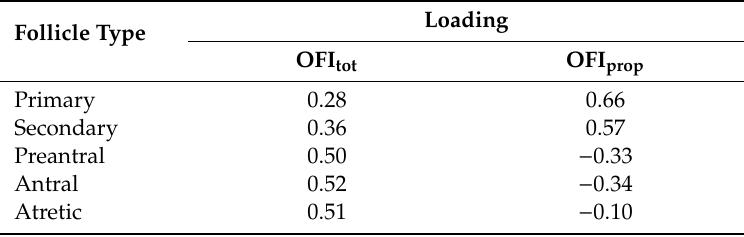
Table 6. Table of variable loadings from the principal component analysis.